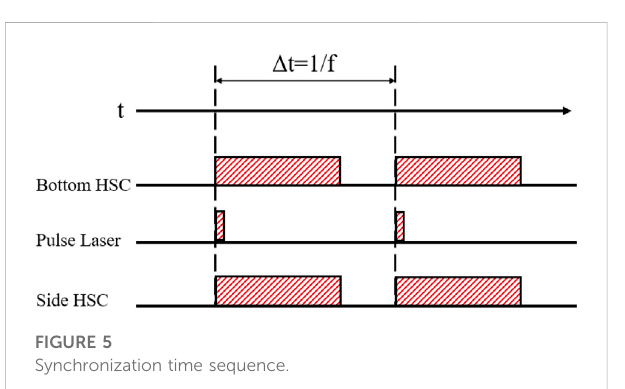
FIGURE 5 Synchronization time sequence.